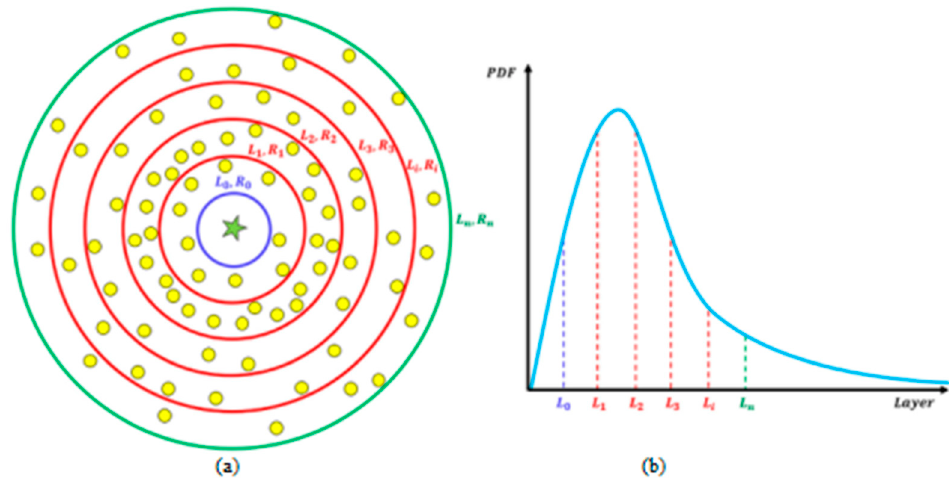
Figure 1. Schematic presentation of imaginary layers around nucleus. The AOS algorithm used a log-normal Gaussian distribution function to build the mathematical model based on the quantum excitation model of the atom. Figure 2 represents the determined positions of the electrons (candidate solutions) with a log-